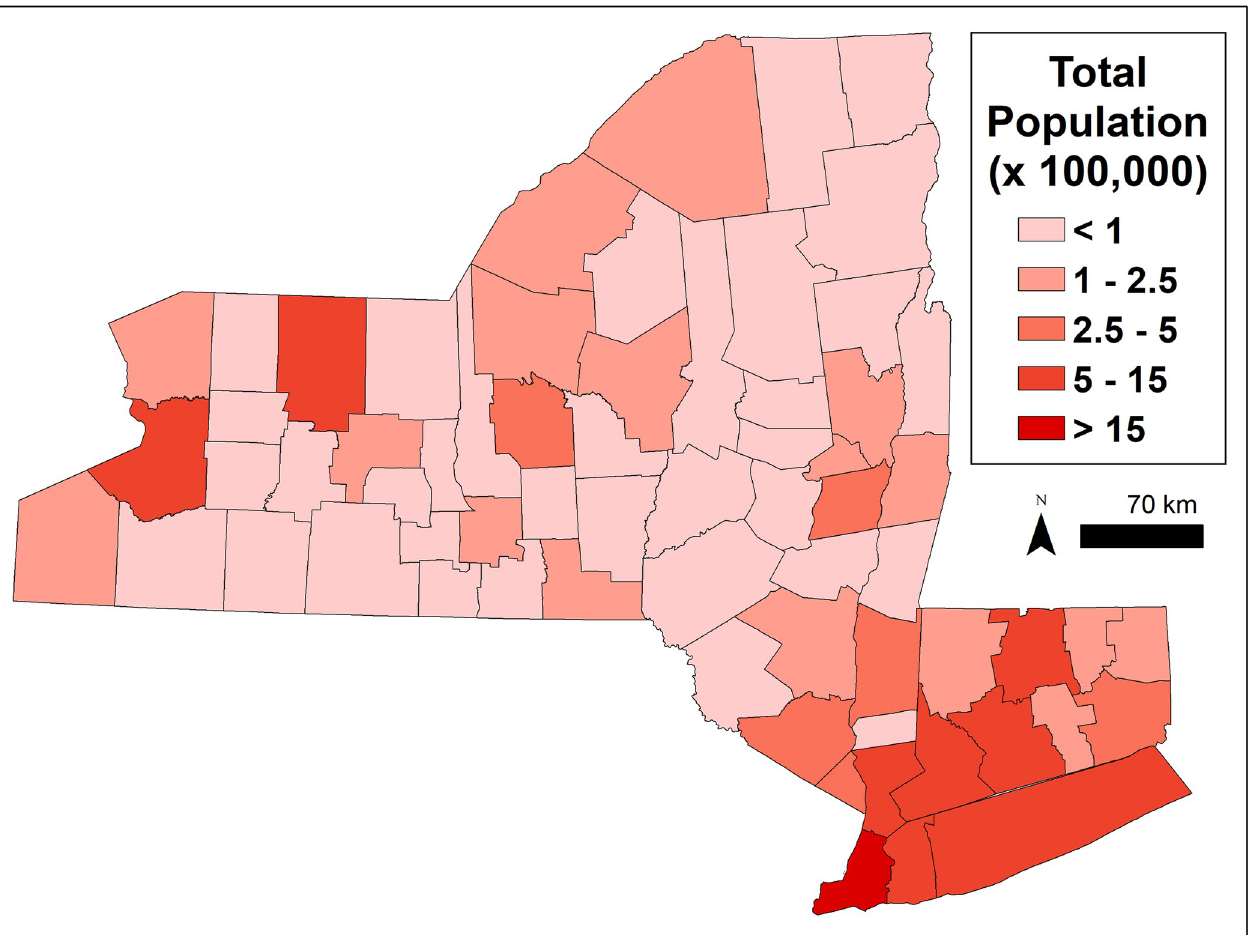
Fig 11. Total human population of the study region. Note that the five counties of New York City have been merged into a single entity. Data taken from the US Census